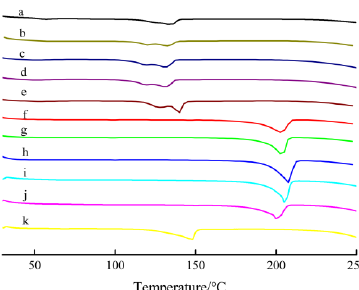
Figure 2. DSC curves of poly( L -lactic acid) (PLLA), PDLAG, and stereocomplex of poly(lactic acid) containing glucose groups (sc-PLAG) samples with different glucose content in feeding, a. PDLAG-5%; b. PDLAG-4%; c. PDLAG-2%; d. PDLAG-1%; e. PDLAG-0.5%; f. sc-PLAG-5%; g. sc-PLAG-4%; h. sc-PLAG-2%; i. sc-PLAG-1%; j. sc-PLAG-0.5%; k. PLLA. Table 2. Thermal properties and crystallinity of PLLA, PDLAG, and sc-PLAG samples. Sample Glucose Content in Feeding/ % T g /°C T m /°C Crystallinity/%